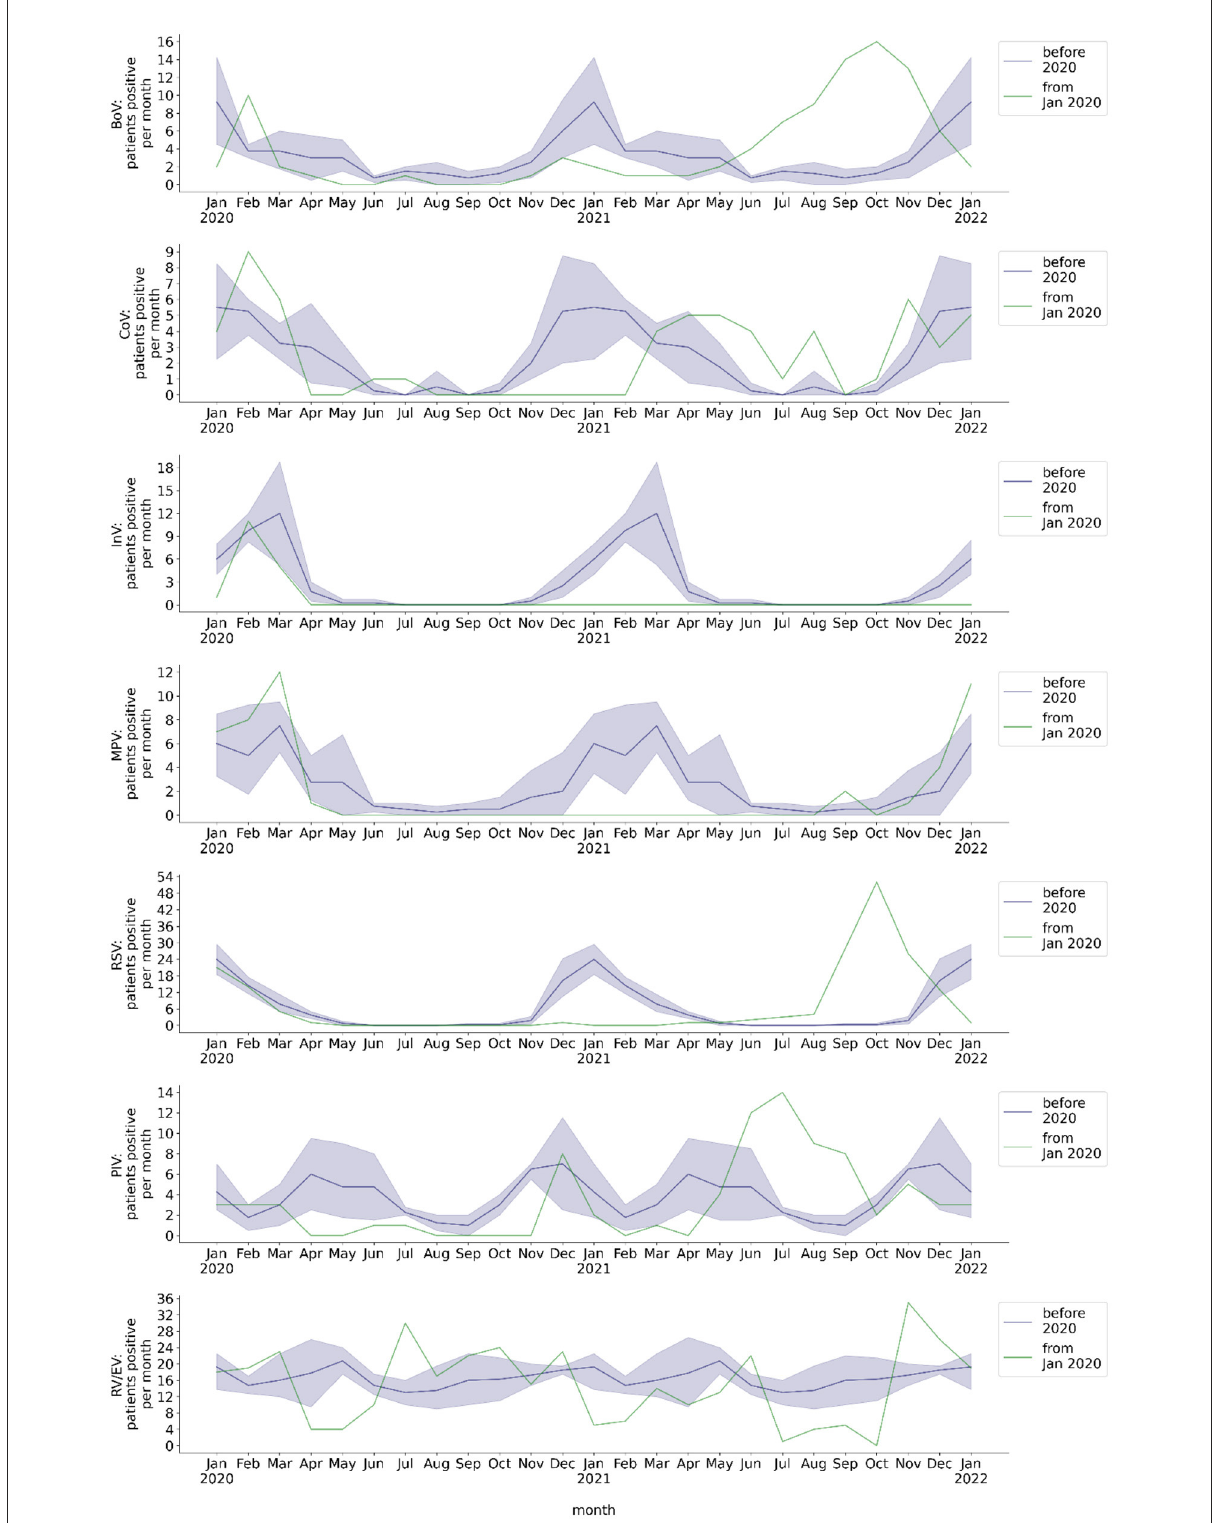
FIGURE3 Monthly number of hospitalized patients at BCH positively tested for respiratory viruses. Blue line: mean 2016-2019, blue shade: 95% confidence interval 2016-2019, green line: absolute number per month from 2020, calendar months 2016-2019 are shown as a historical reference and correspond to calendar months, not to year on x-axis. Number of patients per month with respiratory sample tested positive for BoV, CoV, InV, MPV, RSV, PIV, or